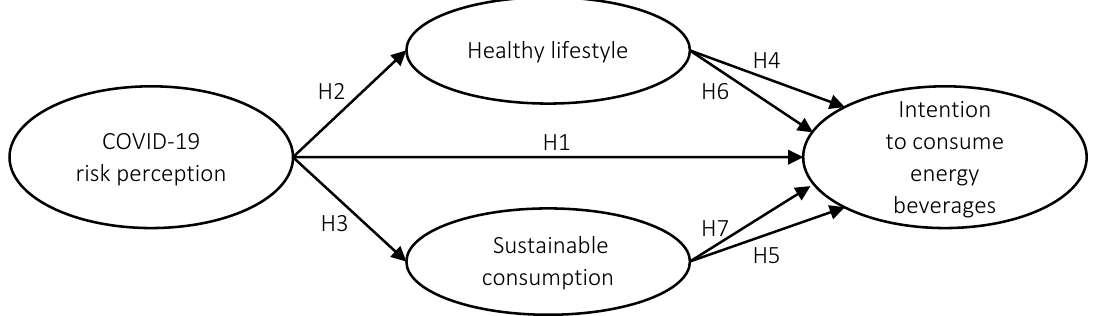
Figure 1. Conceptual